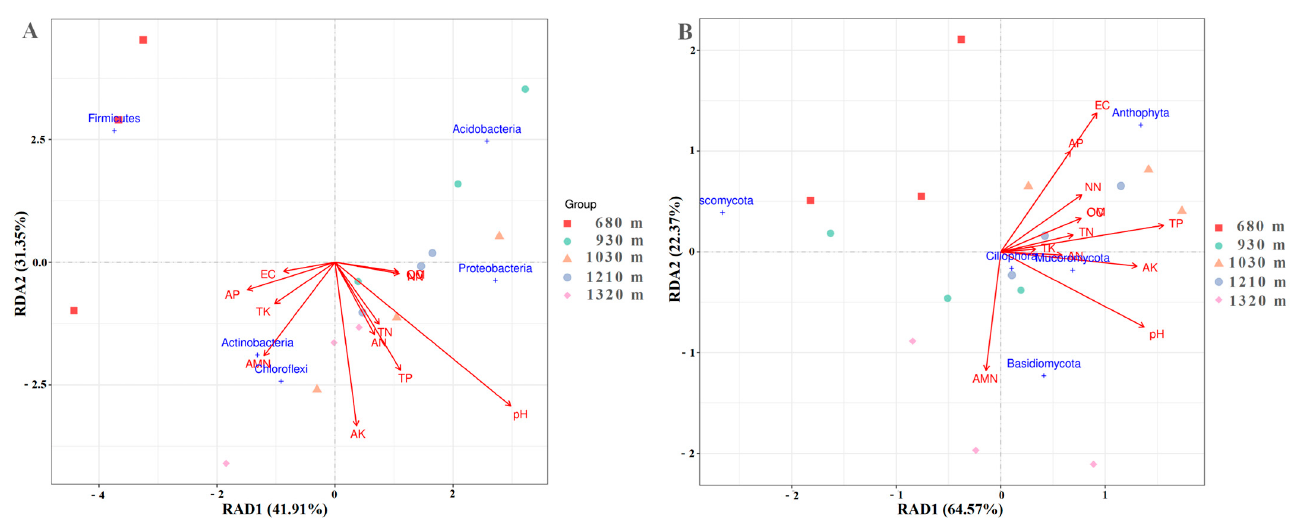
Figure 8. Correlations between microbial phyla and soil physicochemical properties. ( A ) Redundancy analysis (RDA) of the top five bacterial phyla and soil physicochemical properties. ( B ) RDA of the top five fungal phyla and soil physicochemical properties. Data are presented for the rhizospheric soil samples collected at altitudes of 680, 930, 1030, 1210, and 1320 m. OM, OC, TN, TP, TK, AN, NN, AMN, AP, and AK represent organic matter, organic carbon, total nitrogen, total phosphorus, total potassium, available nitrogen, nitrate nitrogen, ammonium nitrogen, available phosphorus, and available potassium, respectively.